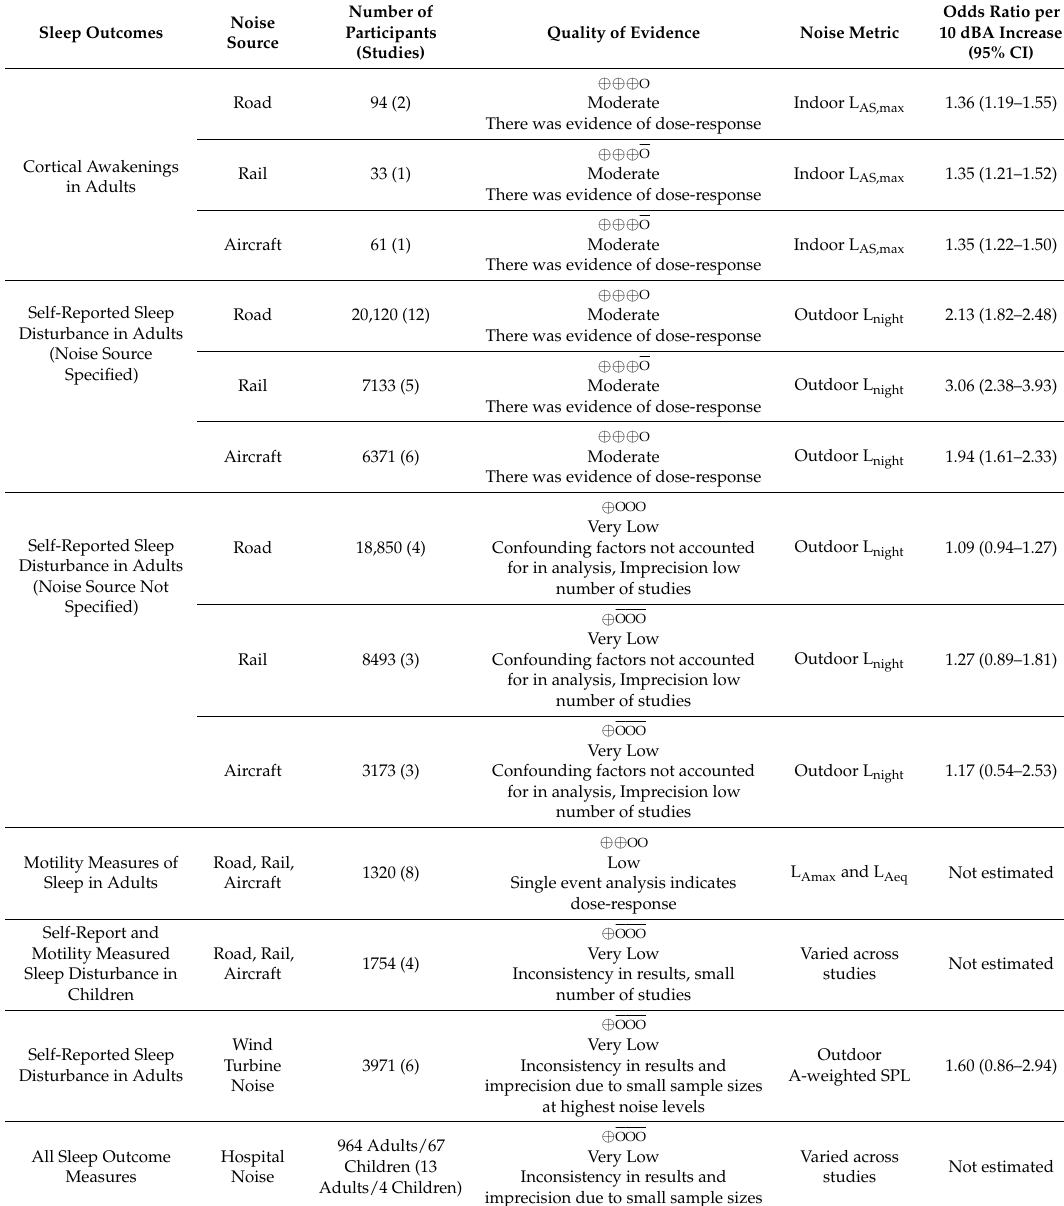
Table 13. Summary of findings.